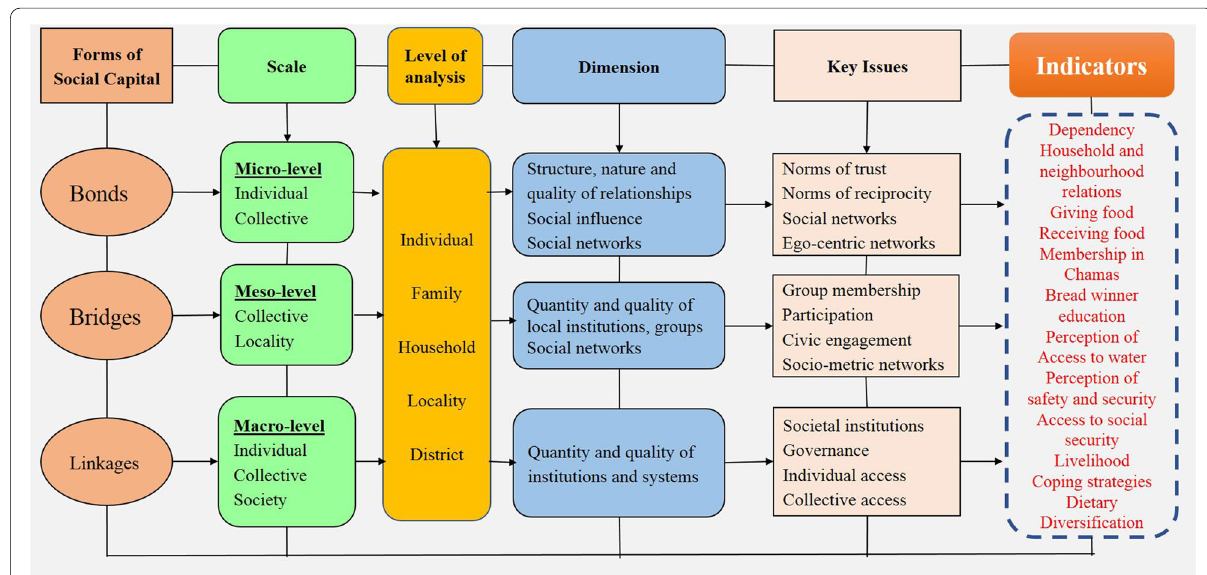
Fig. 1 Social capital conceptual framework adapted from Mpanje et al. (2018) demonstrating the use of context-specific